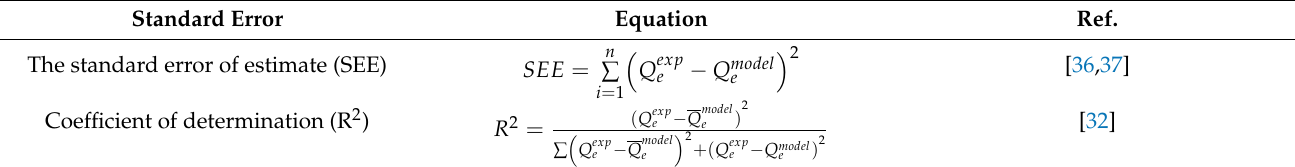
Table 3. Linear expressions of error